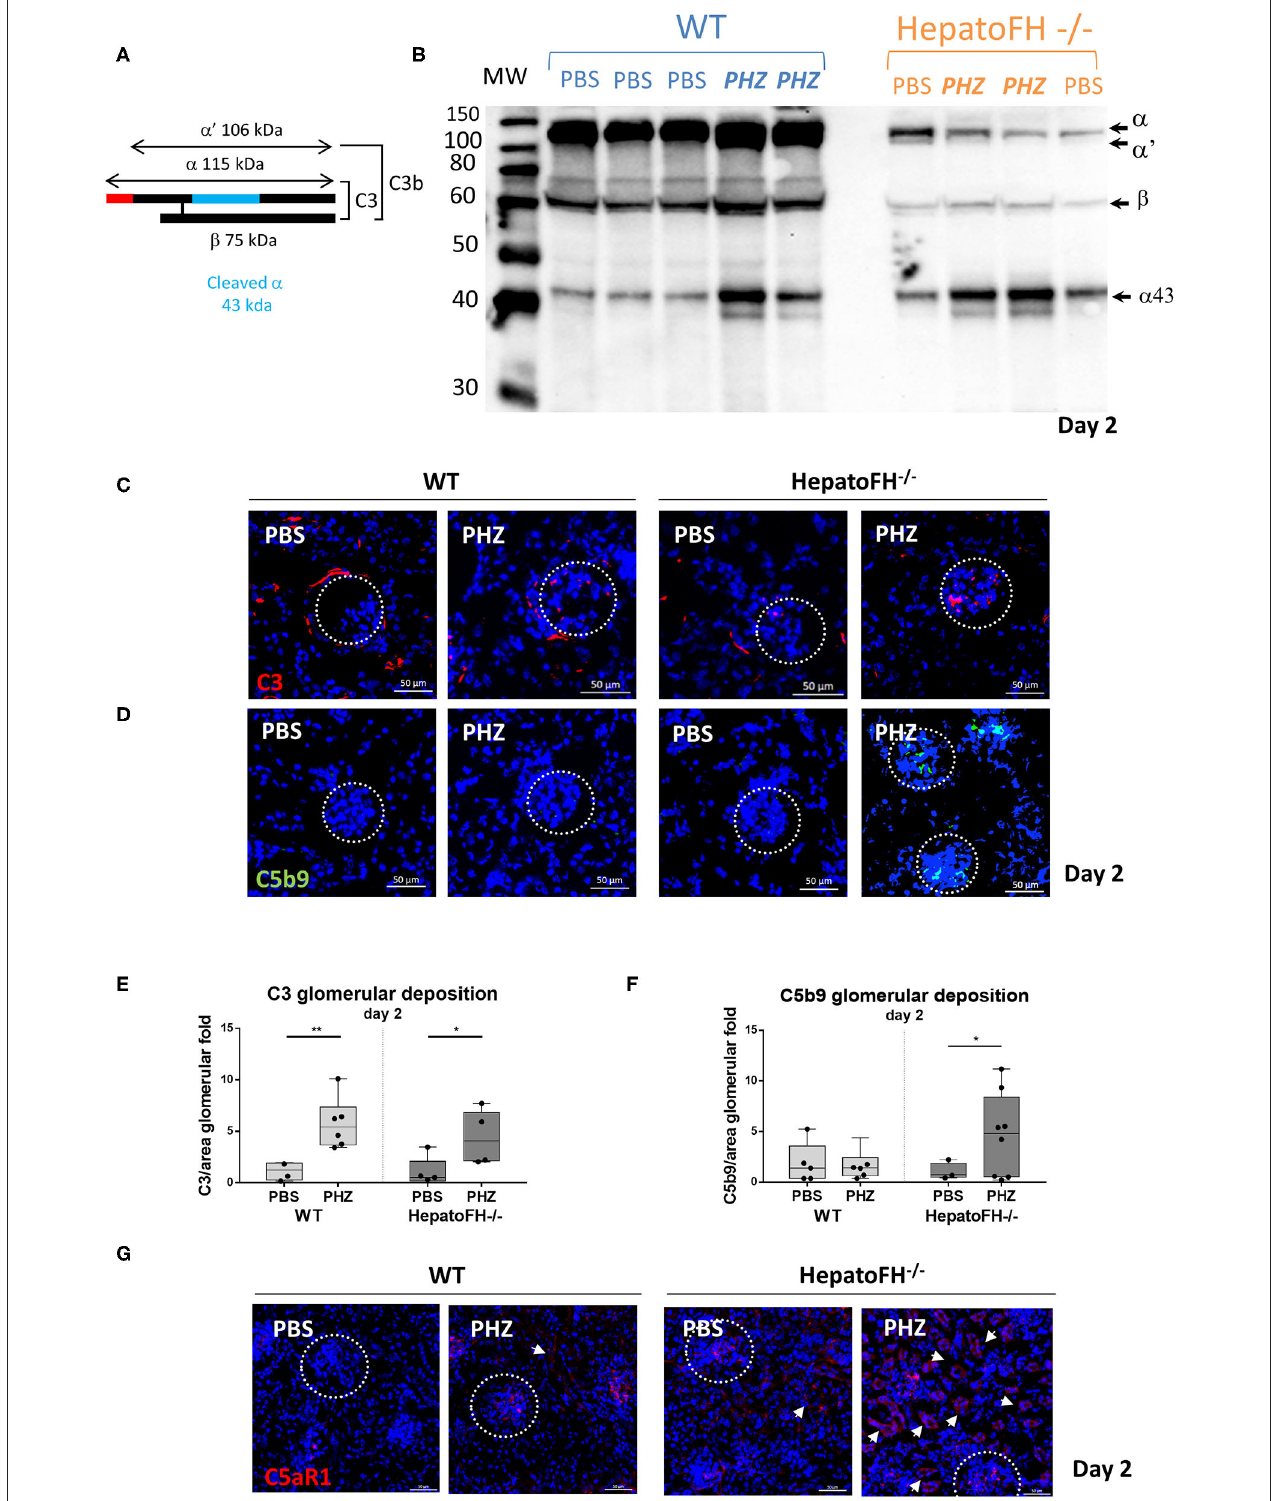
FIGURE 4 | Lack of circulating FH leads to formation of the membrane attack complex in glomeruli and C5aR1 upregulation in tubules. (A) Schematic represetation of complement C3, indicating the different chains and cleavage fragments to be detected by WB. (B) Evaluation of C3 cleavage by WB after PBS or PHZ injection (Day 2) in WT and hepatoFH − / − mice. Each lane correspond to 1 individual mouse. A mixture of purified C3 and C3b was used as a positive control to distinguish the